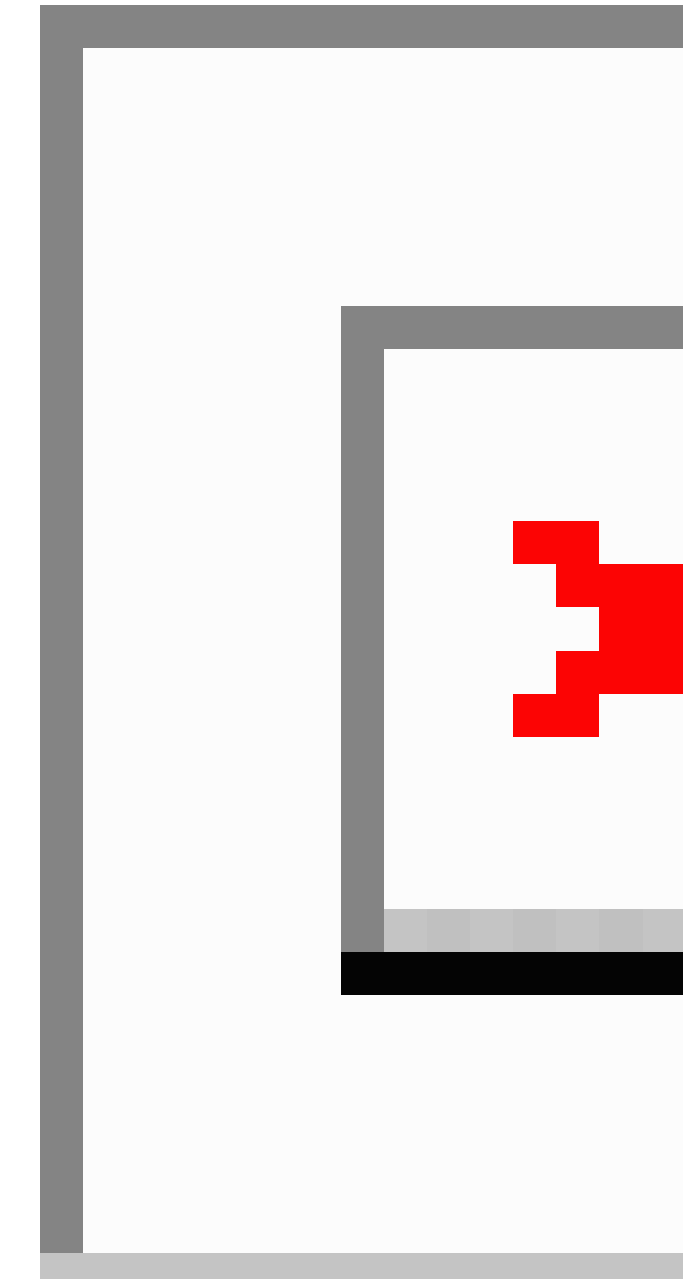
Figure 1. Study area (highlighted area), Ladkrabang district of Bangkok,